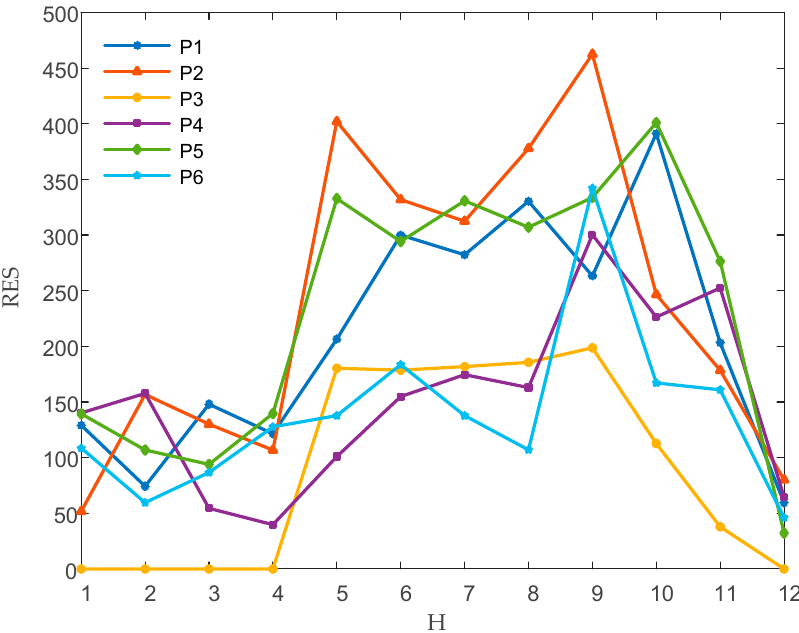
Figure 10. The original RES generation profiles of multiple prosumers.